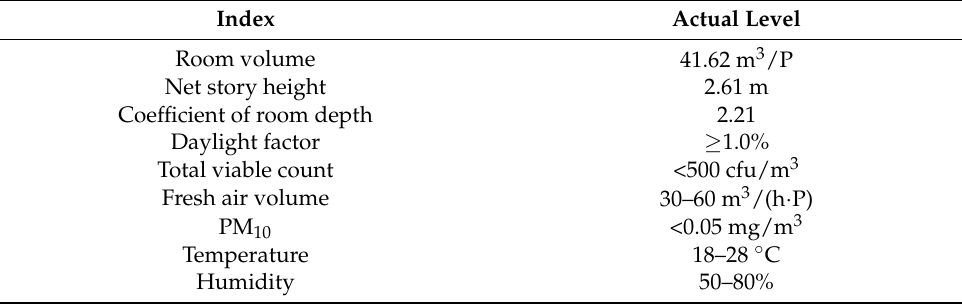
Figure 2. It contains the infrastructure of the standard ward (shown in part of the figure), pollutant injection points, and 7 (A to G) sampling positions. In addition, HEPA is installed 2 m above the head of the bed, and PNOI is installed at the central air conditioning outlet on the right side of E. Table 1. Index of indoor environment in simulation ward.